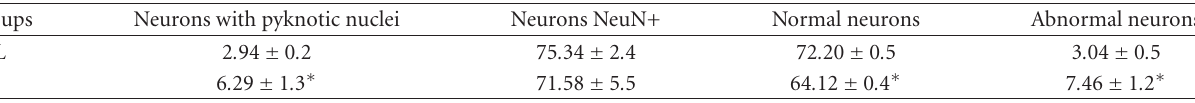
Table 1: Analysis of neuron cells in CA1 hippocampal area.